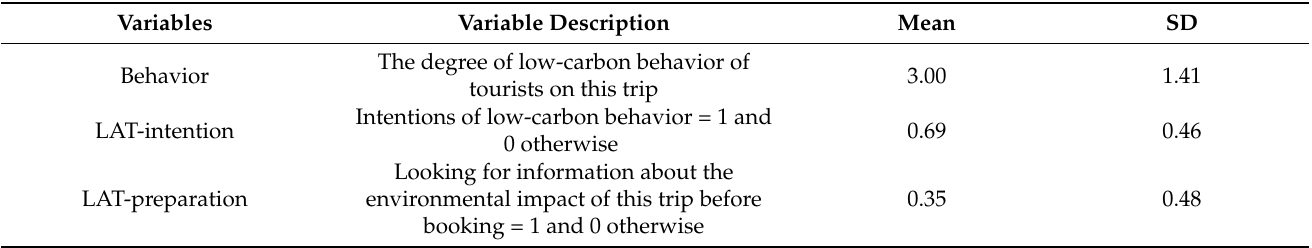
Table 4. Definitions of the